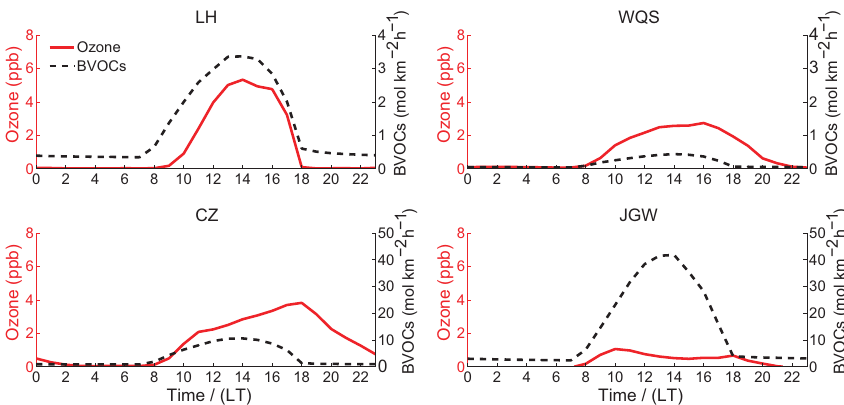
Fig. 8. Diurnal variations of modeled surface ozone changes and the BVOC emission rate at 4 monitoring sites. The red dashed line shows surface ozone changes (ppb) while the black solid line shows the BVOC emission rate (molkm − 2 h − 1 ).